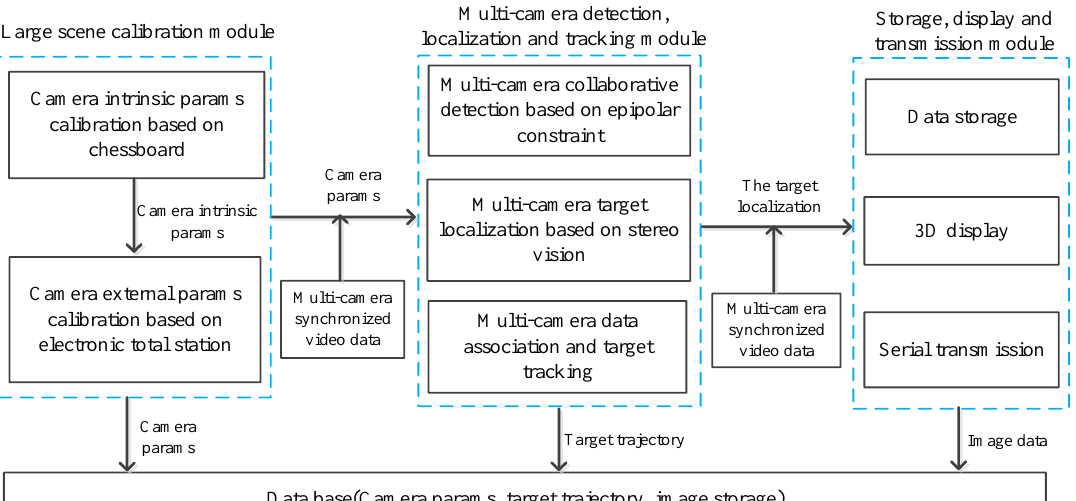
Figure 2. The framework of the infrared camera array system.